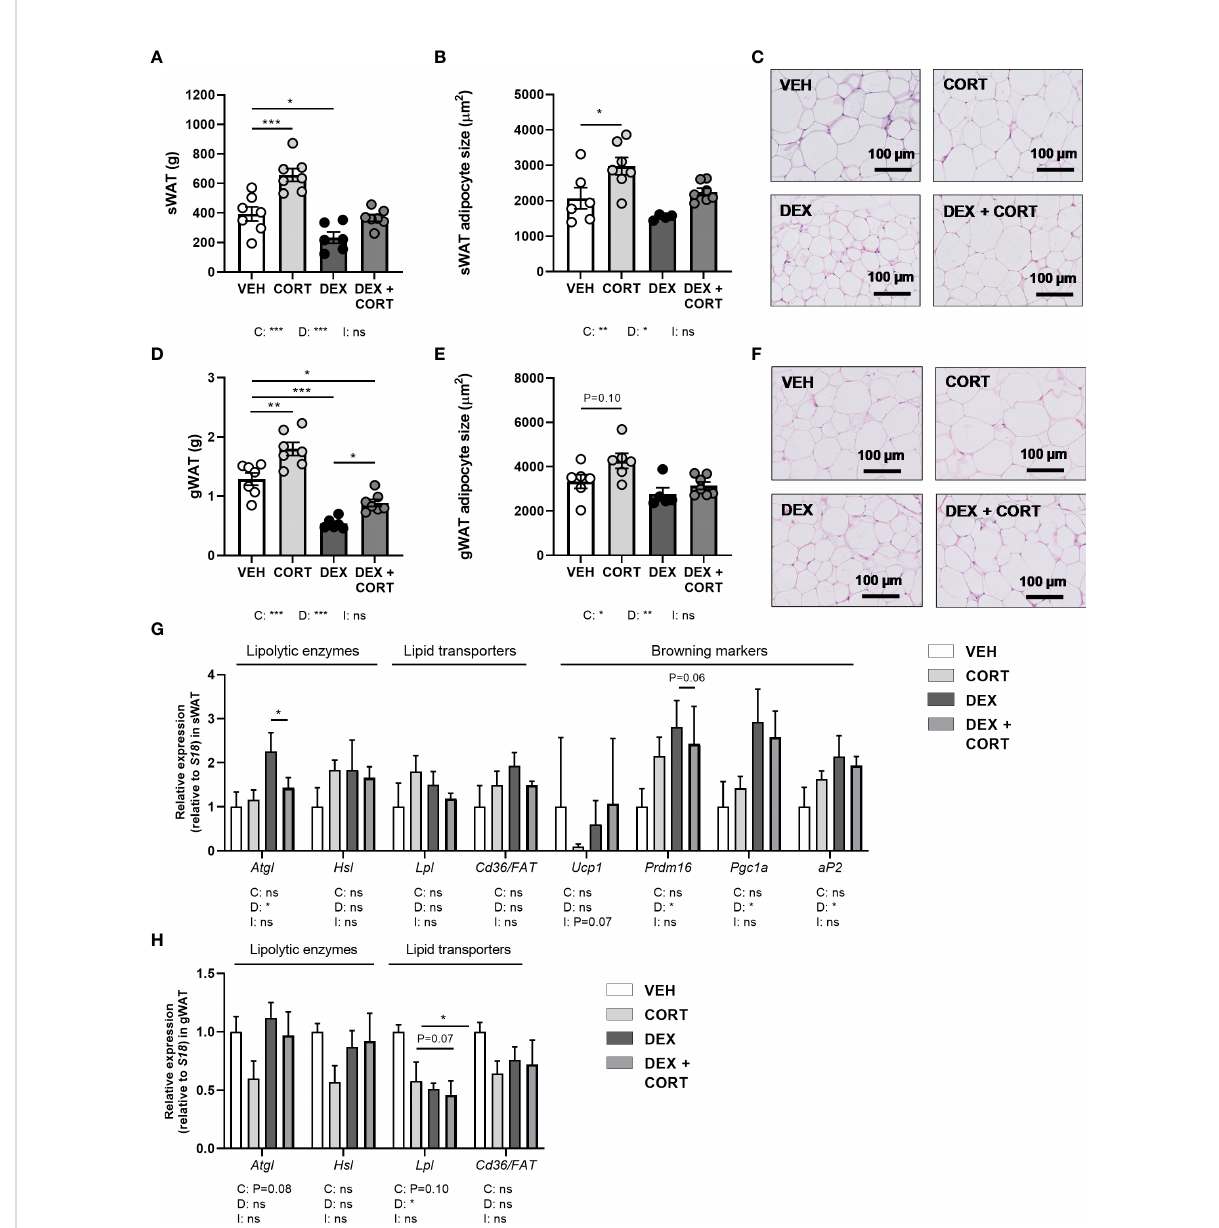
FIGURE 3 Dexamethasone stimulates expression of lipolytic enzyme Atgl in WAT, which is prevented by corticosterone add-on treatment. Mice received a high-fat diet mixed with dexamethasone (DEX) or vehicle (VEH) and were subcutaneously implanted with low-dose (5 mg) corticosterone (CORT) or vehicle pellets for 3.5 weeks. DEX decreased tissue weight and adipocyte size, as determined by H&E staining, in (A – C) subcutaneous white adipose tissue (sWAT) and in (D – F) gonadal white adipose tissue (gWAT). (G) In sWAT, DEX increased the expression of lipolytic enzyme Atgl and browning markers Prdm16, Pgc1a and aP2. DEX + CORT prevented the DEX-induced upregulation of Atgl expression. (H) In gWAT, DEX did not affect Atgl, Hsl , or Cd36/FAT expression, but decreased Lpl expression. Statistical signi fi cance was calculated using 2-way ANOVA analysis. Depicted below the graphs are the P-values of the ANOVA tests for either CORT (C) or DEX (D) treatment or the interaction between CORT and DEX (I). *P < 0.05, ** P < 0.01, ***P < 0.001. 'ns' means 'not signi fi